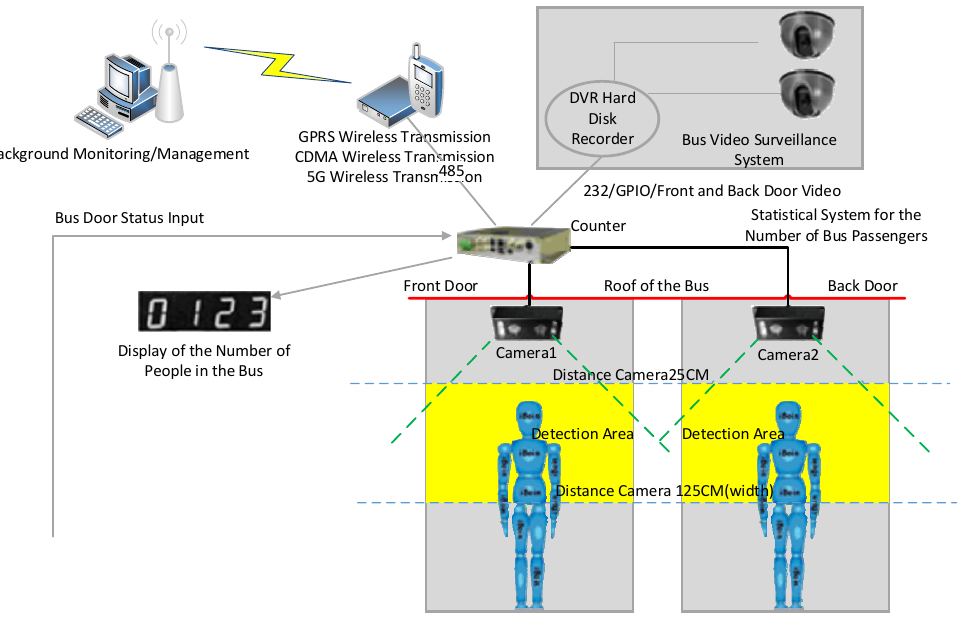
Figure 1. Flowchart of bus passenger flow analysis.